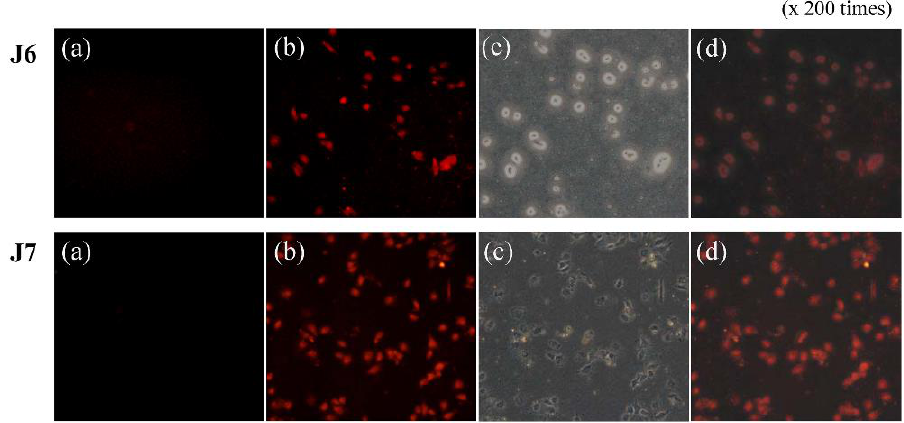
Figure 10. ( a ) Fluorescent images of ECV304 incubated with 10 μmol L −1 J6/J7 for 30 min; ( b ) a further incubation with 10 μmol L −1 copper ions for 2 h; ( c ) bright-field image of ( b ); ( d ) an overlay image of ( b ) and ( c ).